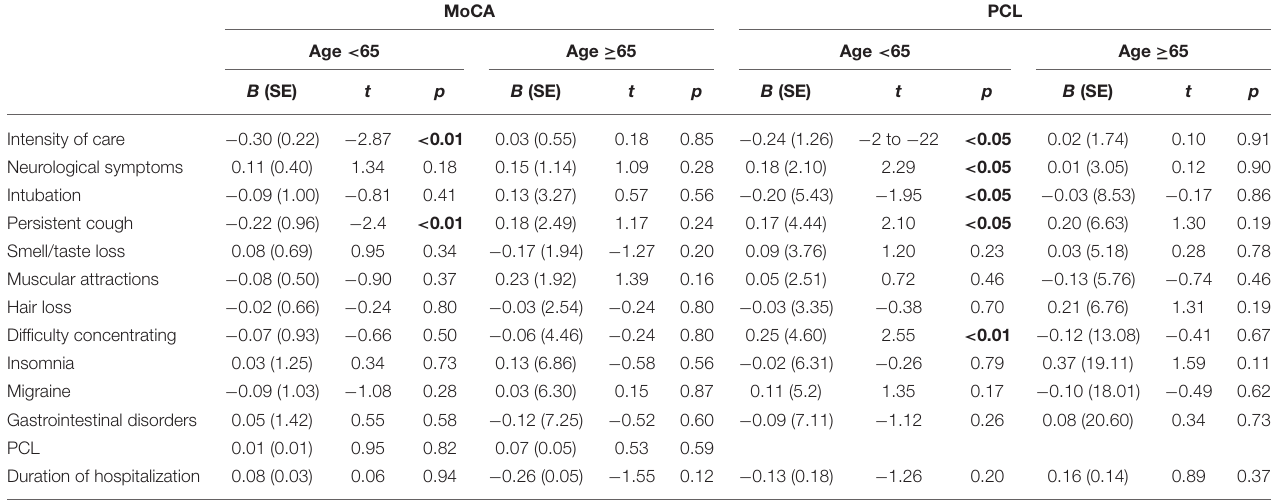
TABLE 3 | Shows linear regression models for the sample sorted by